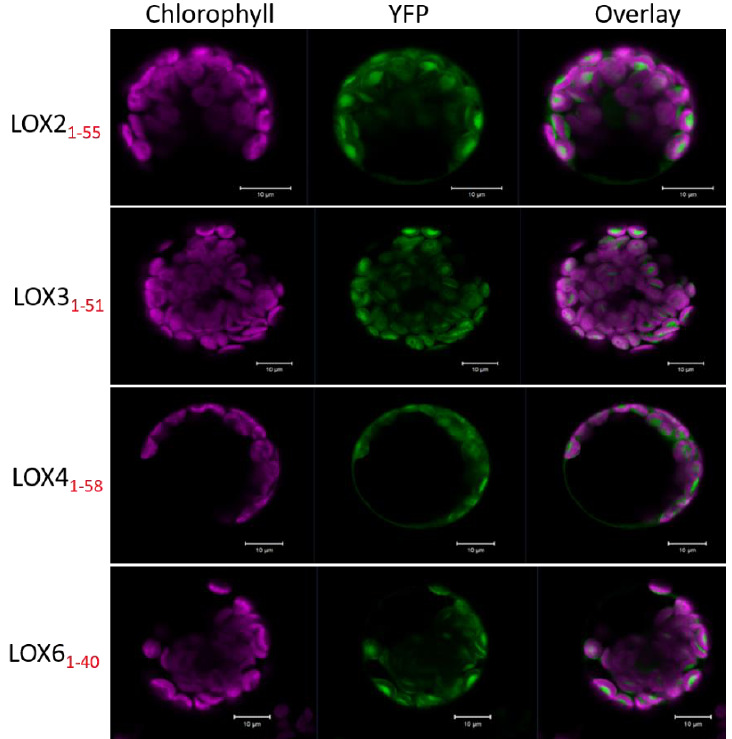
Figure 2. Subcellular localization of fusions of 13-LOXs N-terminal sequences with YFP. Fluores- cence microscopic analyses of A. thaliana protoplasts transfected with YFP-constructs (LOX2 1-55 -YFP, LOX3 1-51 -YFP, LOX4 1-58 -YFP, LOX6 1-40 -YFP) revealed that the indicated sequences target the reporter to the chloroplast, as shown by the overlay (merge) of the YFP fluorescence signal (green) with chloroplast autofluorescence (magenta). The same pattern of co-localization was observed in several protoplasts. Size bars: 10 μm.